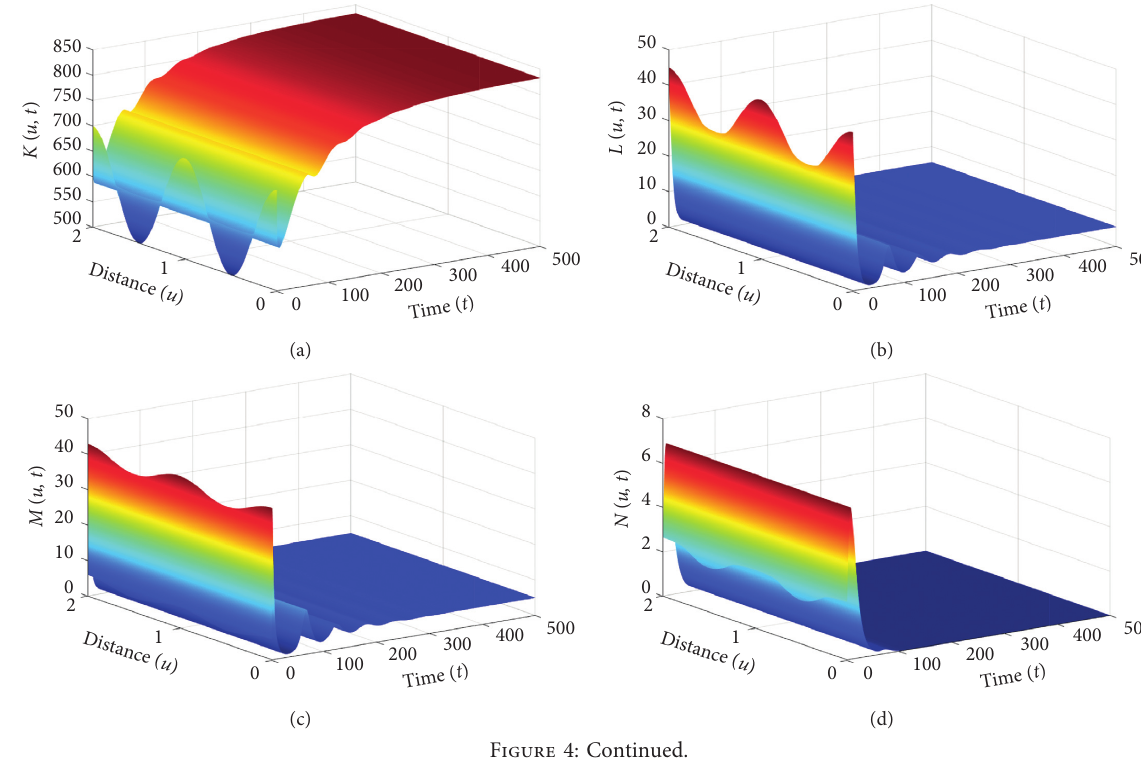
Figure 3: Taking Strategy 1 ( R cells. (b) DENV-infected cells. (c) DENV particles. (d) Heterologous antibodies. (e) Homologous